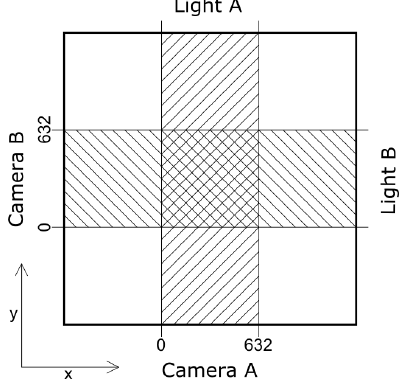
Figure 3. A schematic view of the 2-DVD measuring area seen from